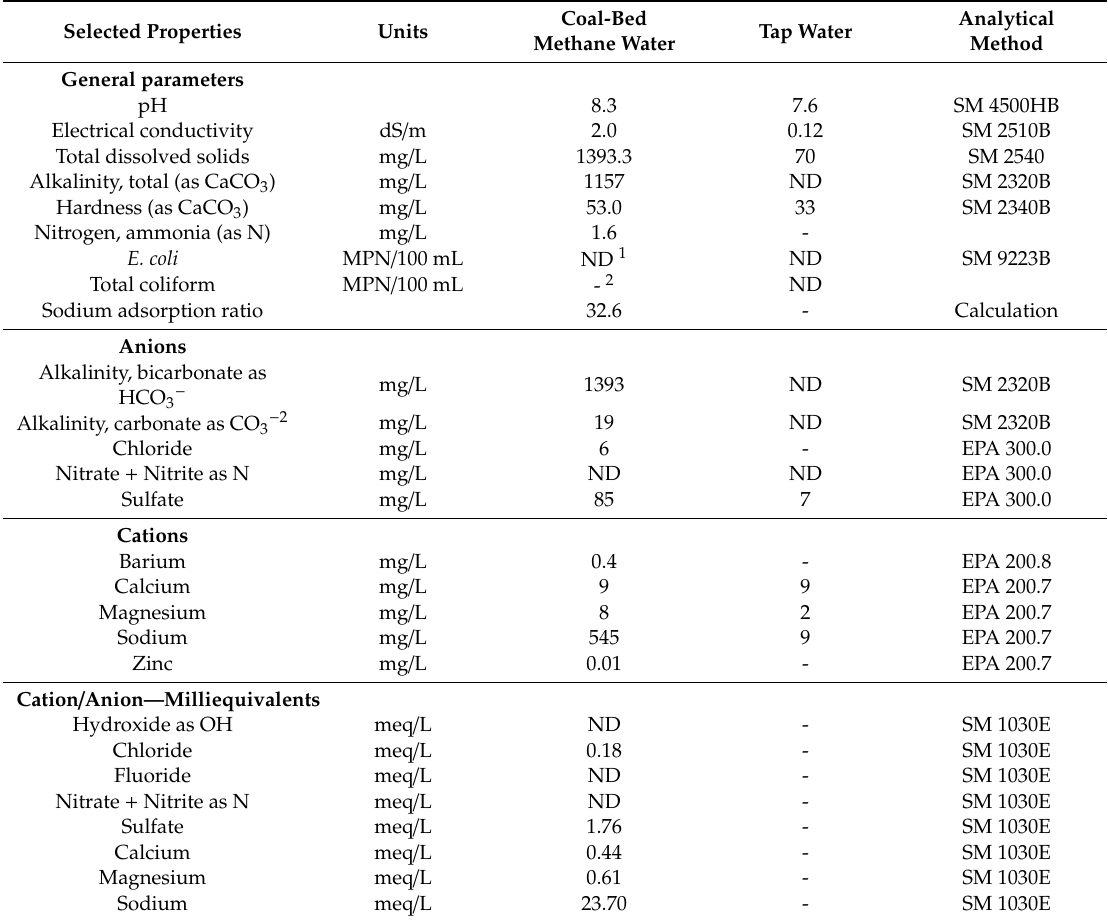
Table 1. Selected properties of coal-bed methane water and tap water used in this study. Selected